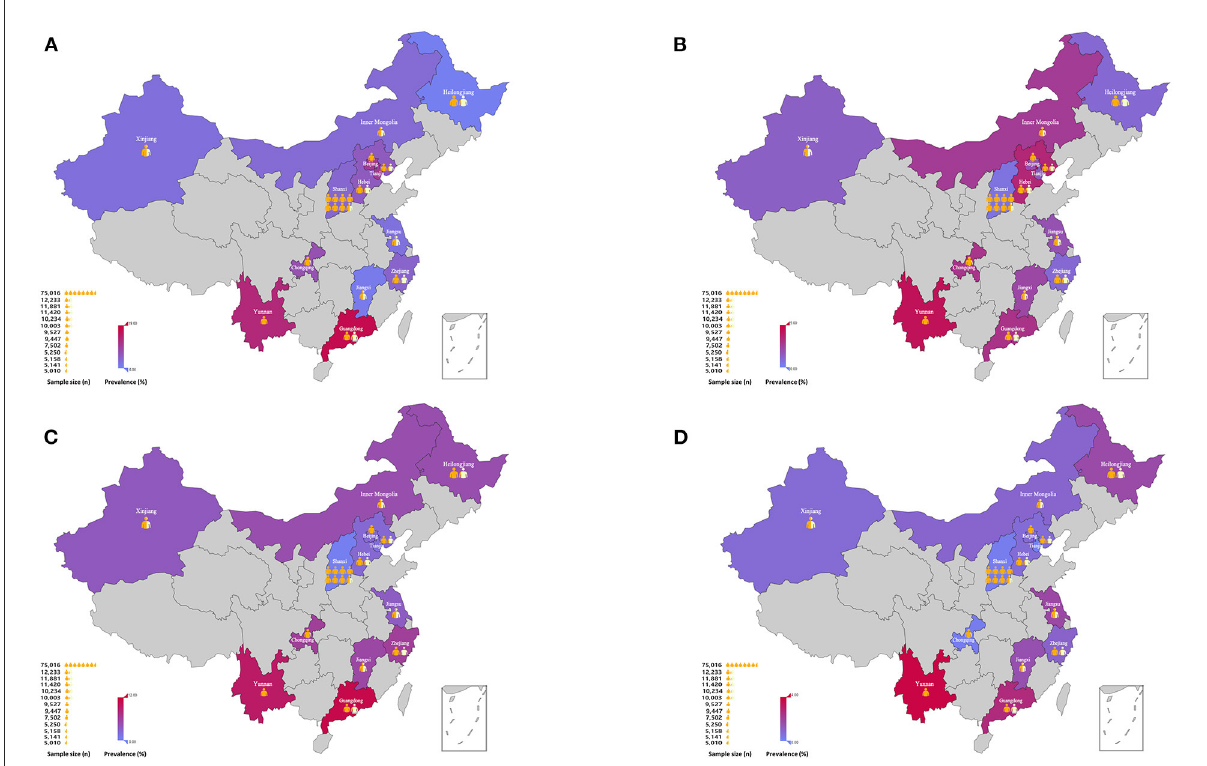
FIGURE1 Geographical distribution of population-based studies in prevalence of low vision and blindness using the WHO criteria in mainland China. (A) the prevalence of low vision based on PVA; (B) the prevalence of blindness based on PVA; (C) the prevalence of low vision based on BCVA; (D) the prevalence of blindness based on BCVA. WHO, World Health Organization; PVA, presenting visual acuity; BCVA, best corrected visual